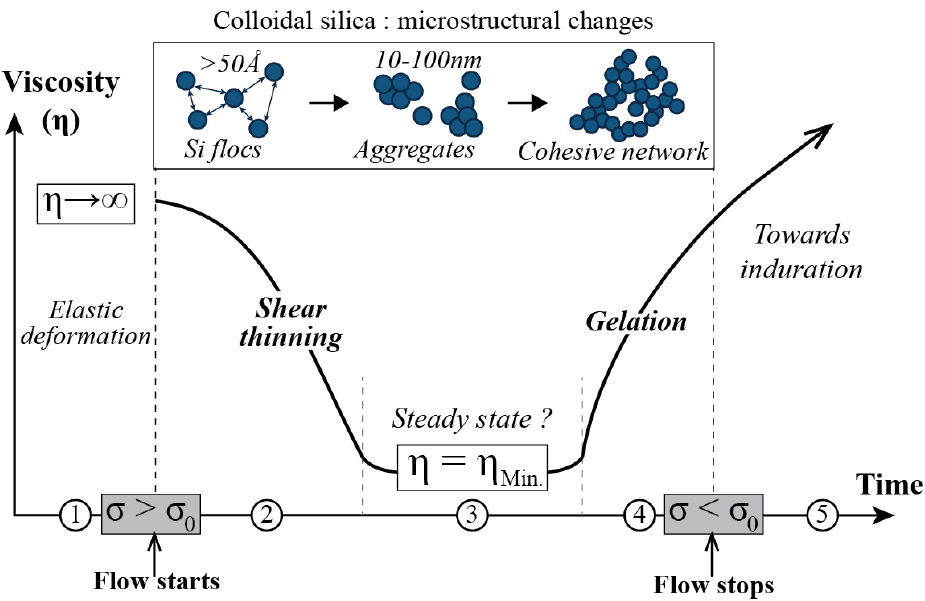
Figure 15. Simplified model showing the expected viscosity variations of the slurry through time. See Sect. 4.3.2 for the description of the various steps. The sketches in the inset illustrate the gelation process of silica that triggered viscosity variations. Floc aggregation starts early within the flow through particle-particle collisions. Then, as the shear stress decreased, the formation of a cohesive silica network rapidly increased the viscosity, and allowed large country rock fragments to stay suspended within the